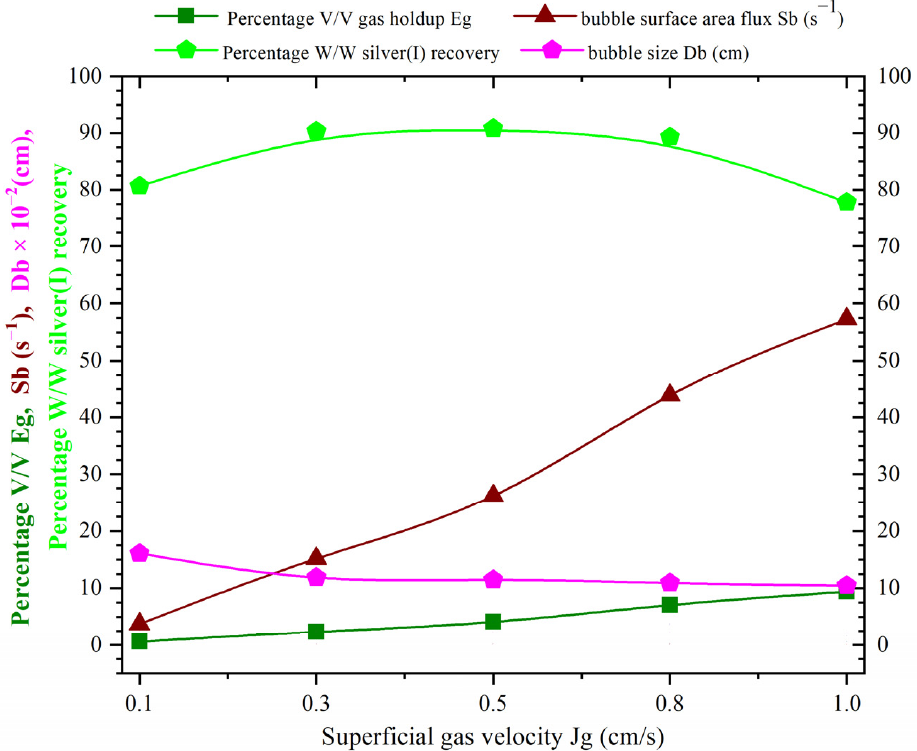
Figure 9. Eg, Db, Sb, and percentage of w / w of silver(I) ion flotation as a function of superficial gas velocity, ceramic sparger, Jl 0.19 cm/s, [e] 1.25 × 10 − 4 M, and xanthate concentration 3.77 × 10 − 4 M.